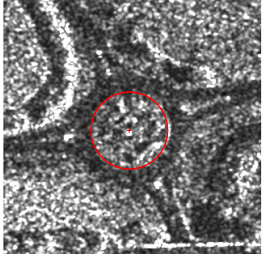
Figure 4: The roundabout in the SAR image and the extracted circle (red) and center position (red + ) after the matching